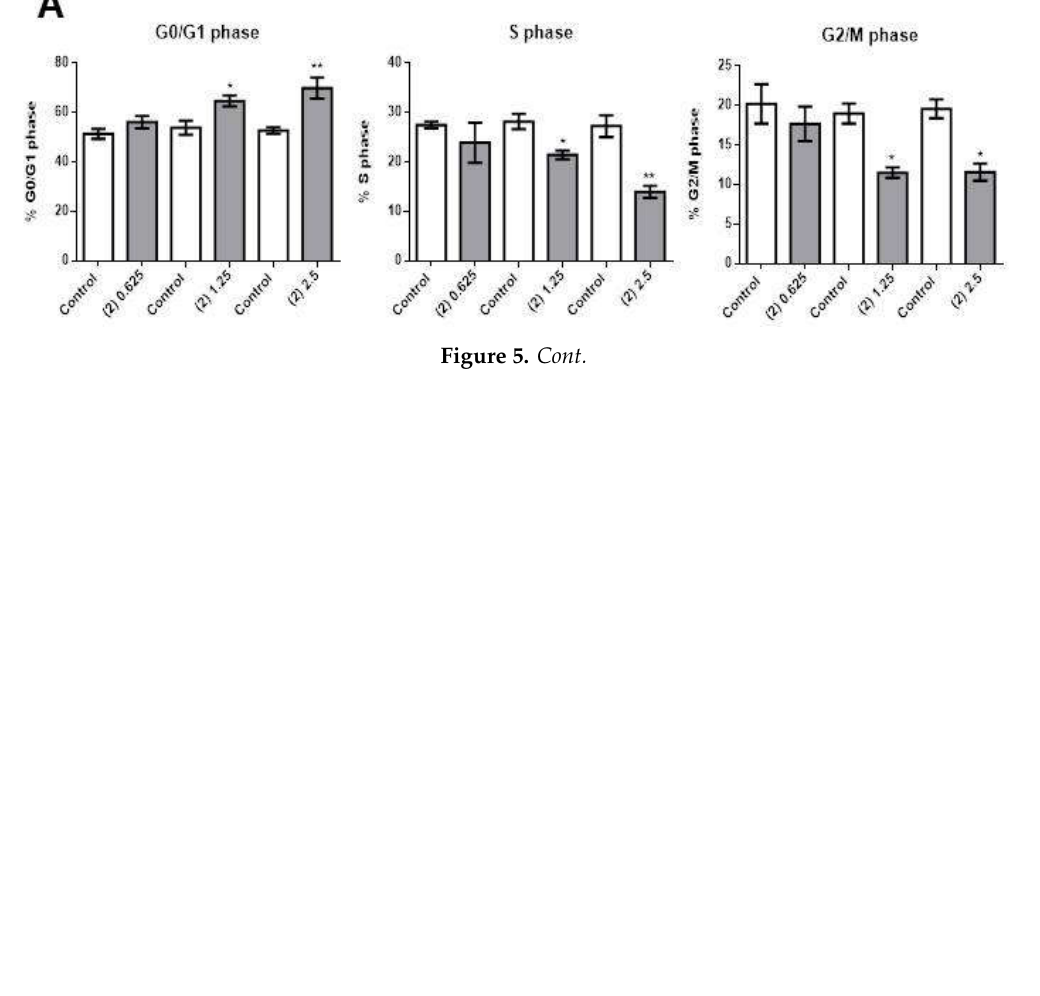
Figure 4. Effects of compound 2 on OCI-AML3 cell number and apoptotic cell death. ( A ) Bars represent the cell number (left panel) or the percentage of apoptotic cells after 24 h of treatment with control vehicle (Control) or 0.625 [(2) 0.625)], 1.25 [(2) 1.25] or 2.5 [(2) 2.5] µg/mL of compound 2 . ( B ) Flow cytometry analyses of a representative experiment. Data from three independent experiments are reported as mean ± SEM. * p < 0.05; *** p < 0.001.